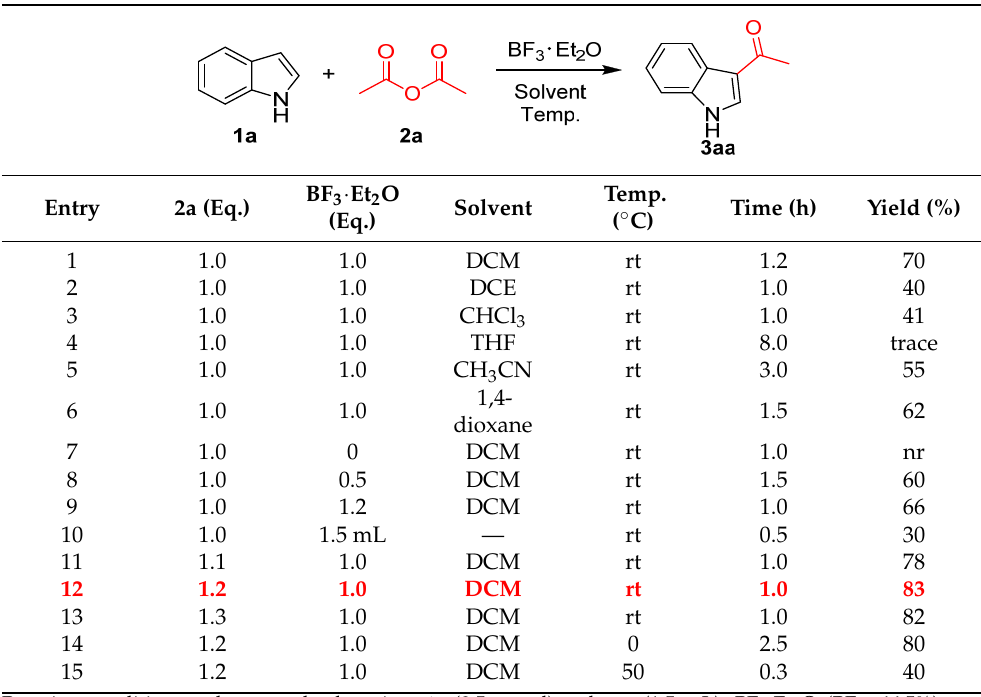
Table 1. Optimization of reaction conditions.